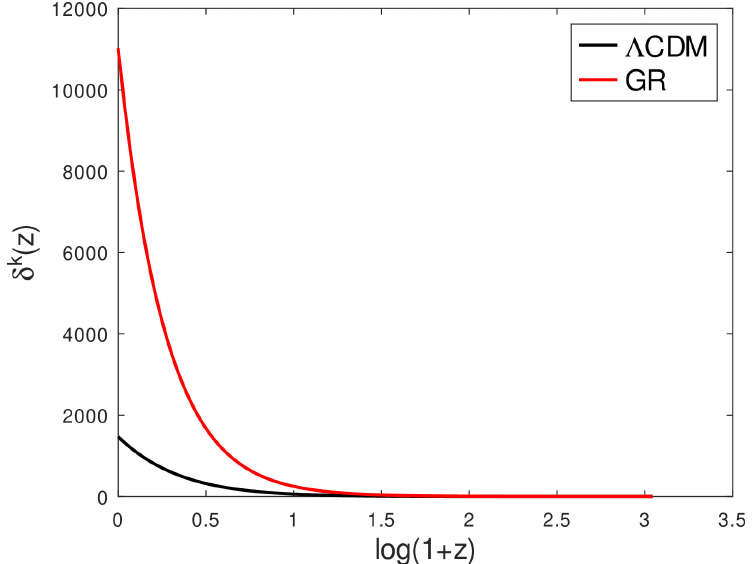
Figure 4. The variation of the matter density perturbations δ k ( z ) for Λ CDM and GR without Λ ( Ω m = 1, Ω Λ = 0) vs. redshift. The current values from [49] h ( 0 ) = 1, Ω m ( 0 ) ≡ Ω m 0 = 0.3111, Ω Λ ( 0 ) ≡ Ω Λ = 0.6889, Ω = − 0.0007, Ω = 1 − Ω − Ω Λ − Ω m 0 χ 0 σ 0 χ 0 have been used for the 0 0 background, whereas ∆ k ( z in ) = 10 − 5 , Z k ( z in ) = 10 − 5 and Σ k ( z in ) = 10 − 5 have been used as initial conditions for the perturbations, along with the fourth-order Runge–Kutta method to integrate the system numerically.